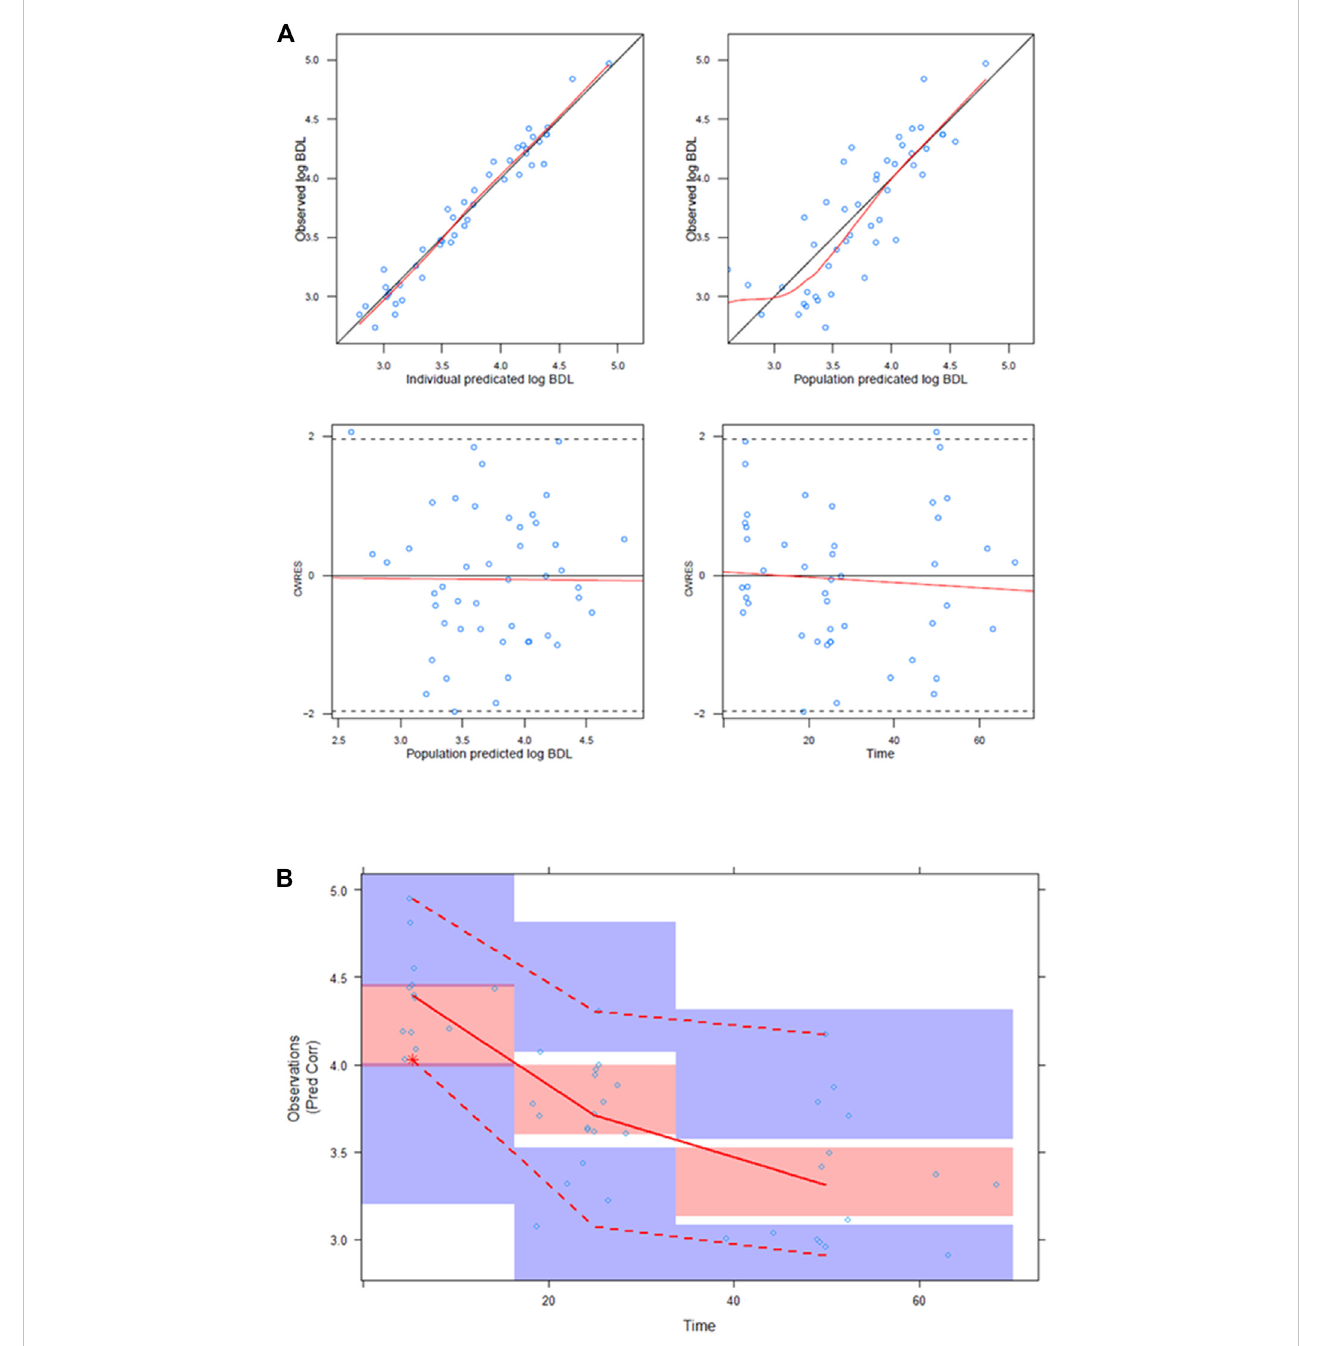
FIGURE 3 Goodness-of- fi t plots and prediction-corrected VPC of the fi nal model: (A) Goodness-of- fi t plots for the PD model. Top left; individual log10 BDL predictionsvs.log10BDLobservations.Topright;populationlog10BDLpredictionsvs.log10BDLobservations.Bottomleft;populationBDLlog10predictions vs. CWRES. Bottom right; time after last dose vs. CWRES. CWRES: conditional weighted residuals. (B) Prediction-corrected VPC of the PD model ( n = 1,000). X -axis: time after last dose; Y -axis, prediction-corrected log10 BDL. Black dots: observations. Blue lines: 10th and 90th percentiles of observations. Red line: median of observations. Blue shaded areas: 95% CIs of simulated 10th and 90th percentiles. Red shaded area: 95% CI of simulated